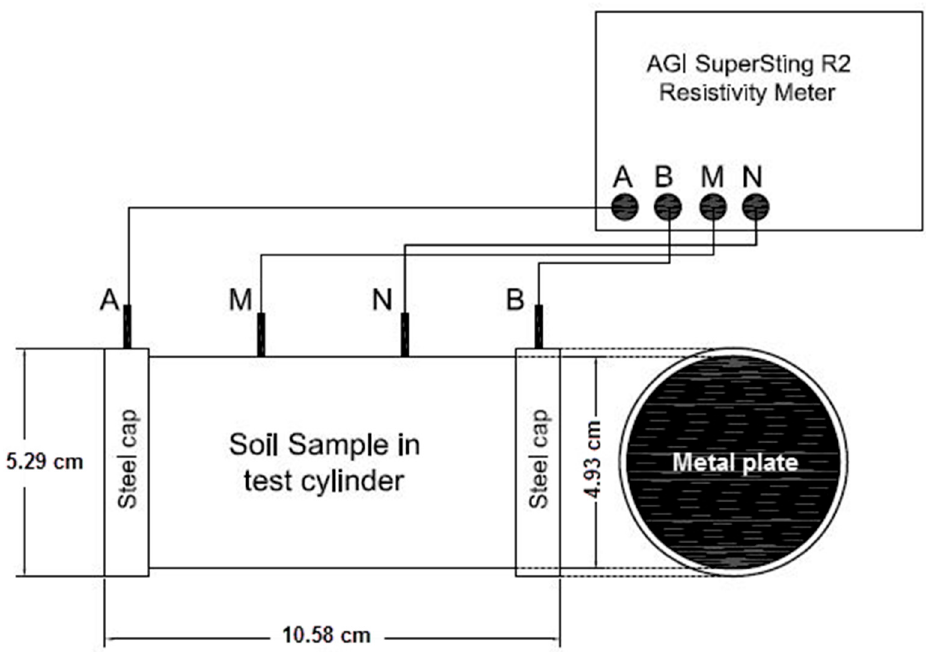
Figure 4. Schematic of sand beach sample measurement in laboratory.